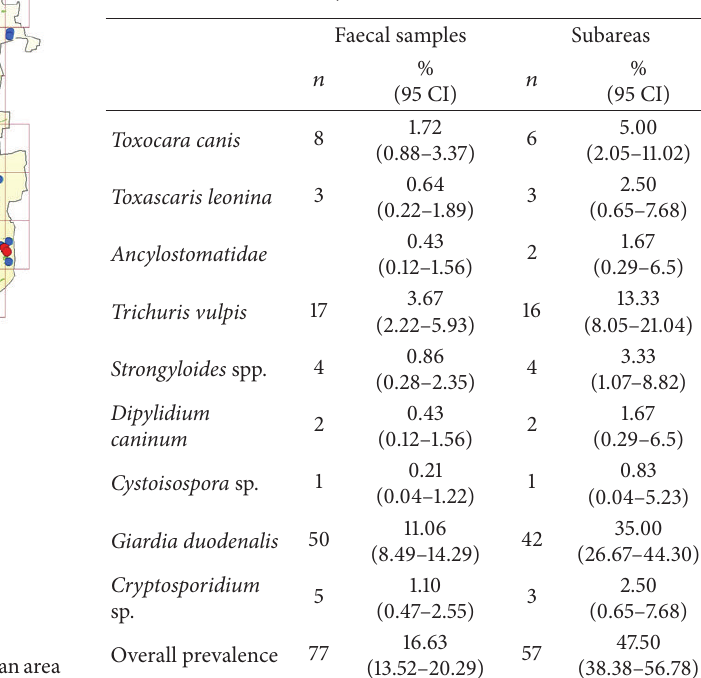
Table 1: Prevalence (%) and 95% confidence interval (CI) of intestinal parasites in 463 dog faecal samples and 120 subareas in Milan (north-western Italy).